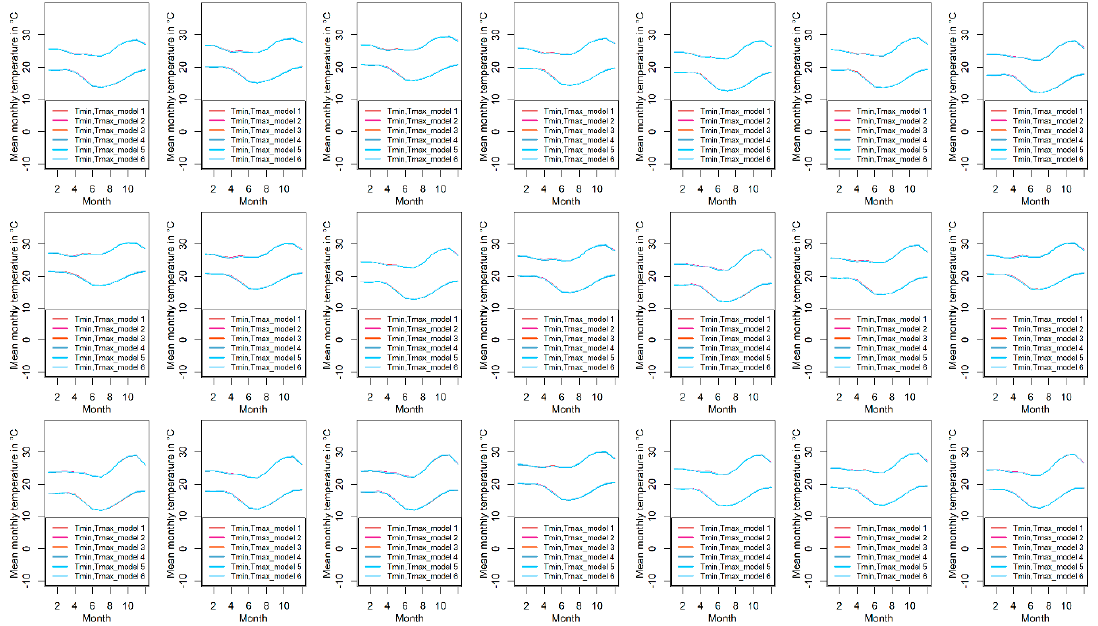
Figure A2. Temperature from 1979–2005 for the 21 utilized CORDEX Africa datagrids after bias-correction with Era-Interim data. Each graph shows the average monthly temperature for all six models after bias-correction in Table 2. Tmin and Tmax represent the mean monthly minimum and maximum temperatures respectively.